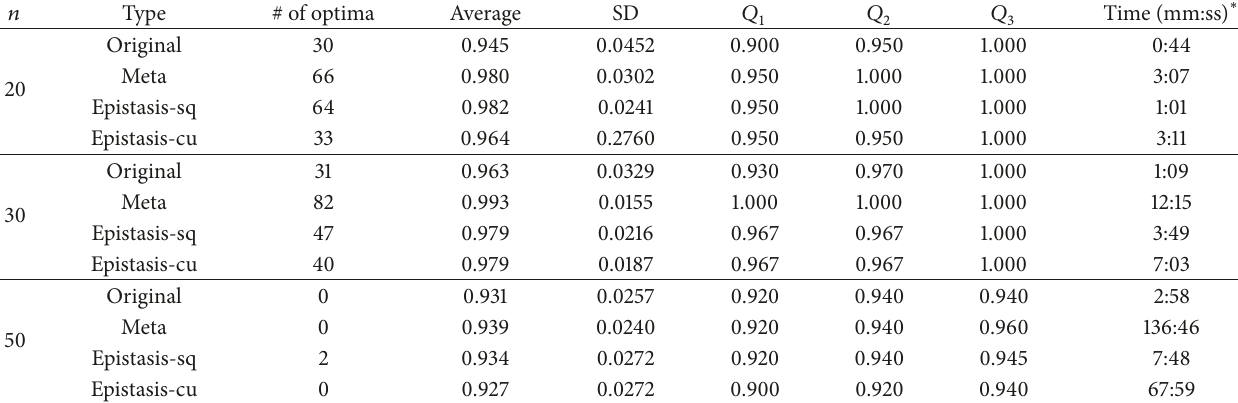
Table 3: Results of each of the best solutions obtained by conducting the GA experiments 100 times on an instance of the variant-onemax problem. (‘# of optima’ is the number of optima found during 100 experiments, ‘Average’ is the average of 100 best solutions, and ‘SD’ is the standard deviation of 100 best solutions. 𝑄 1 ,𝑄 2 , and 𝑄 3 are the first, second, and third quartiles, respectively. ‘Time’ is the sum of the time to search for the basis and that for the GA experiments.)